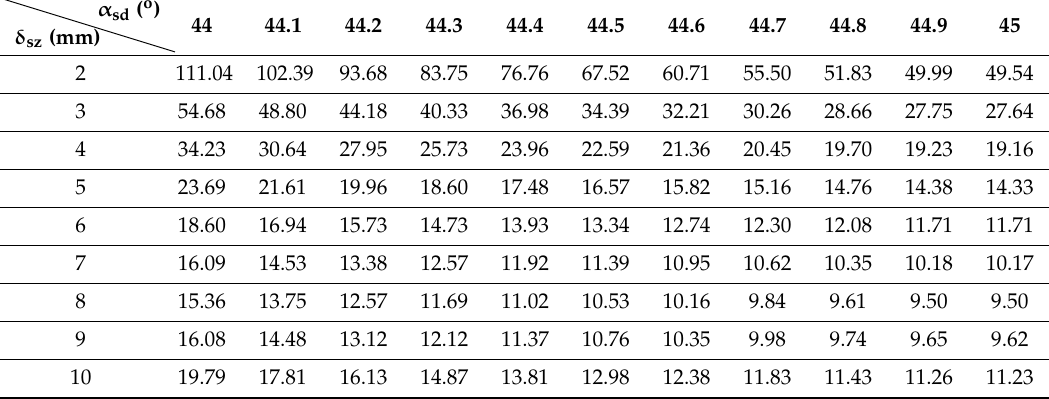
Table 4. List of ratios between useful torque and cogging torque in the DCPM motor being tested for full rotor